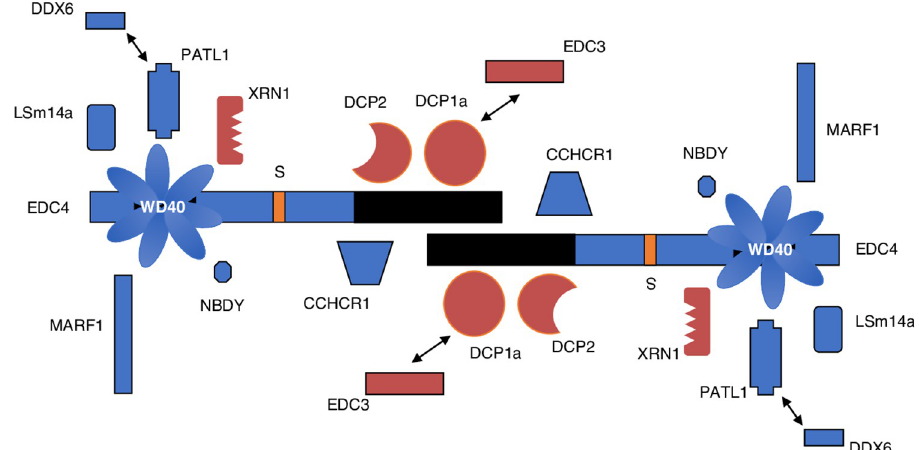
Fig 9. Model of the mammalian mRNA P-body. Interactions between EDC4 and LSm14a, PATL1, XRN1, MARF1, NBDY and DDX6 (via PATL1) require the N-terminal, WD40-containing domain in EDC4. The C-terminus of EDC4 is sufficient to mediate interaction between EDC4 and DCP2, DCP1a, CCHCR1 and EDC3 (via DCP1a). RNA binding proteins DDX6, LSm14a, PATL1, and MARF1 may be present on the “outer surface” of the P-body, while the decapping protein (DCP2) and enhancers of decapping may be “buried”, and perhaps inactive, inside P-bodies. Phosphorylation of NBDY or depletion of LSm14a or DDX6 results in disruption of P-bodies.